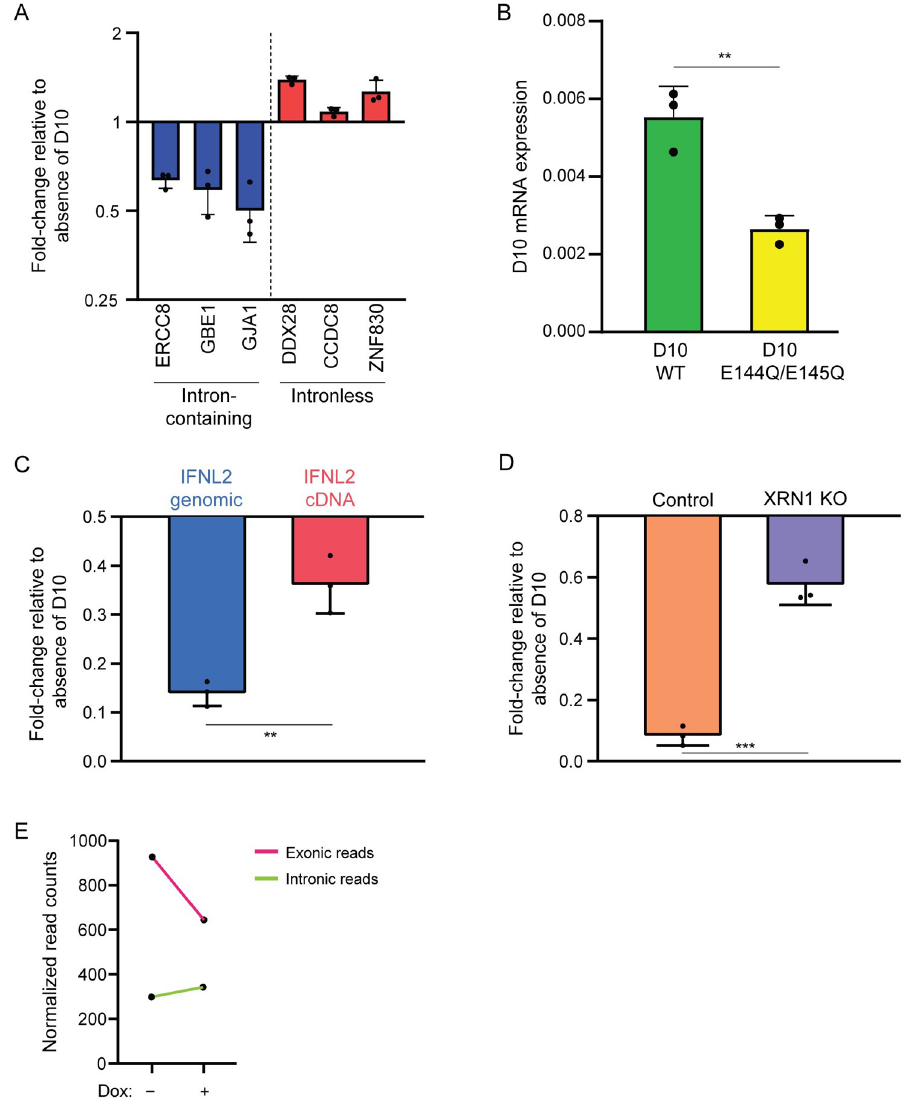
Fig 3. Splicing sensitizes transcripts for stronger decapping by D10. (A) 3xFLAG-D10 WT HEK293T stable cells were either uninduced and dox-induced, and RT-qPCR was used to calculate fold-change of the indicated transcripts in the dox-induced samples relative to uninduced. Each point represents an independent replicate (N = 3). The bars represent the mean value of the replicates and error bars represent standard deviation. (B) 3xFLAG-D10 WT and E144Q/E145Q HEK293T stable cells were dox-induced, and RT-qPCR was used to assess D10 mRNA abundance relative to 18S. Each point represents an independent replicate (N = 3). �� P � 0.01, unpaired t-test. The bars represent the mean value of the replicates and error bars represent standard deviation. (C) HEK293T cells were co-transfected with D10, Adv-VAI, and either the genomic (5 introns) or intronless cDNA version of the IFNL2 reporter. RT-qPCR was used to quantify levels of IFNL2, which were normalized to Adv-VAI RNA, and the fold-change was calculated relative to absence of D10. Each point represents an independent replicate (N = 3). �� P � 0.01, unpaired t-test. The bars represent the mean value of the replicates and error bars represent standard deviation. (D) Control or XRN1 knockout (KO) HEK293T cells were co-transfected with D10, Adv-VAI, and genomic version of IFNL2 reporter. RT-qPCR was used to quantify levels of IFNL2, which were normalized to Adv-VAI RNA, and the fold-change was calculated relative to absence of D10. Each point represents an independent replicate (N = 3). ��� P � 0.001, unpaired t-test. The bars represent the mean value of the replicates and error bars represent standard deviation. (E) The normalized total exonic or intronic read counts from either uninduced (-) or dox-induced (+) 3xFLAG-D10 WT HEK293T stable cells.